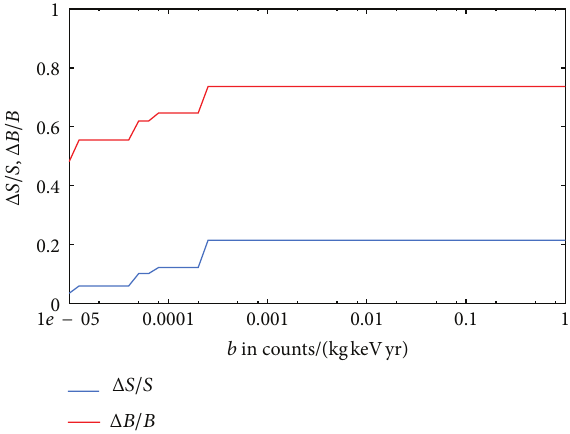
Figure 15: Relative reduction of the number of detected signal events Δ𝑆(𝑏)/𝑆(𝑏) and the number of single-electron background events Δ𝐵/𝐵(𝑏) in the acceptance window as functions of the orig- inal specific single-electron background rate (given in counts/(kg × keV × yr)) for a 3 mm thick CdTe sensor with 165 𝜇 m pixel pitch achieved with the random decision forest.